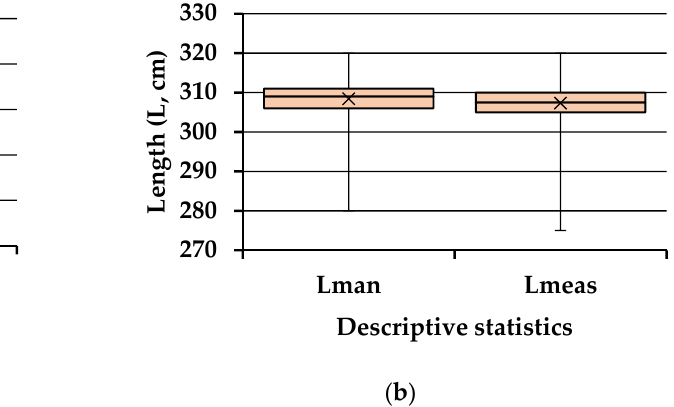
Figure 10. Descriptive statistics of the measured variables (E2): ( a ) Boxplots showing the main descriptive statistics for diameters; ( b ) Boxplots showing the main descriptive statistics for lengths.